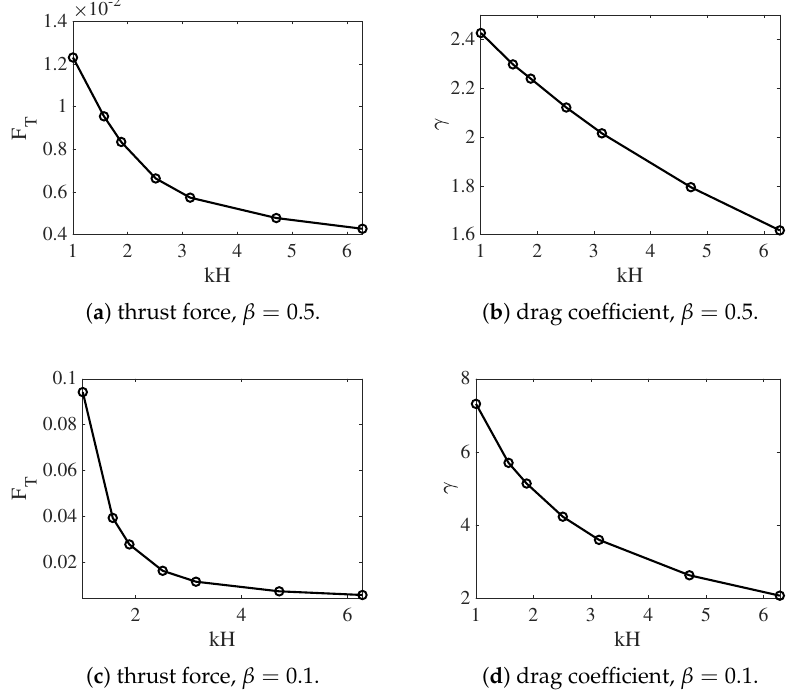
Figure 9. Thrust and drag coefficient vs. the nondimensional interface height kH for different β . The fluid interfaces are